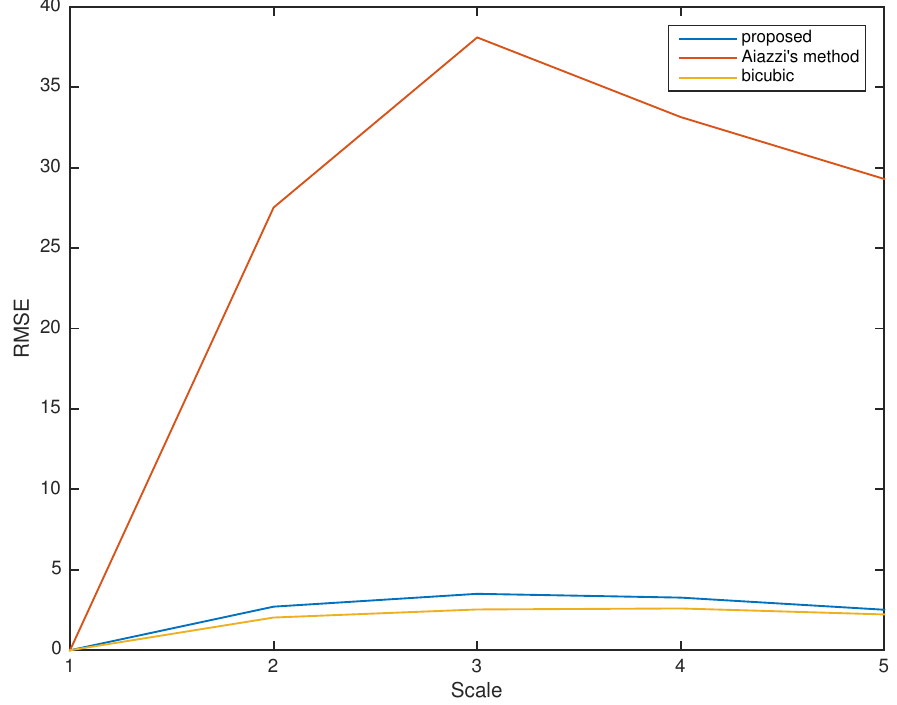
Figure 1. Aiazzi’s method is tested along with bicubic interpolation and the proposed method MSD4FV. The y -axis is the root mean square error (RMSE) between images constructed by direct and iterative spatial degradation strategies, and the x -axis is scale. The testing image is band 5 of a WorldView-2 image for the city of Beijing,